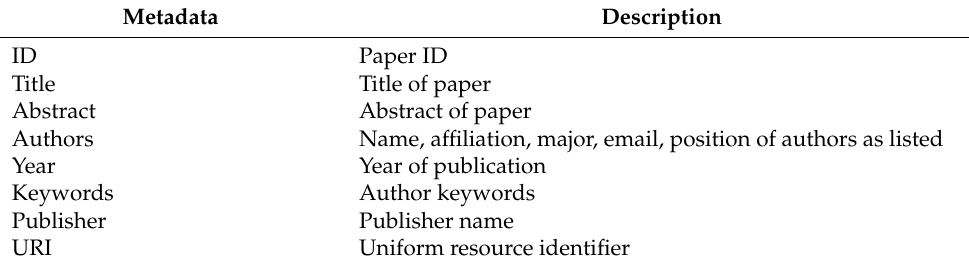
Table 2. Description of the paper